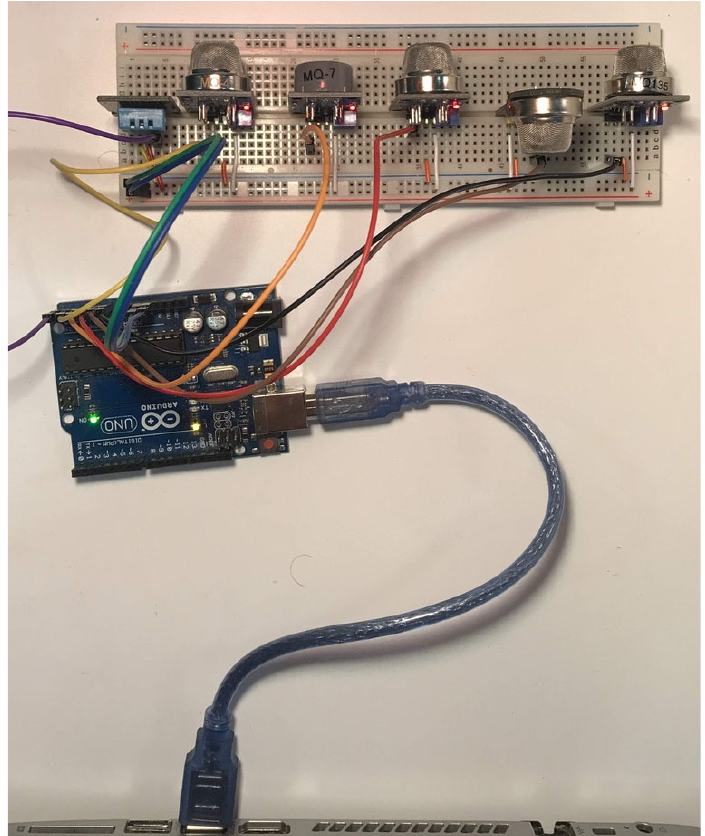
Figure 3. The layout of the coal deposit system physical processes monitoring.